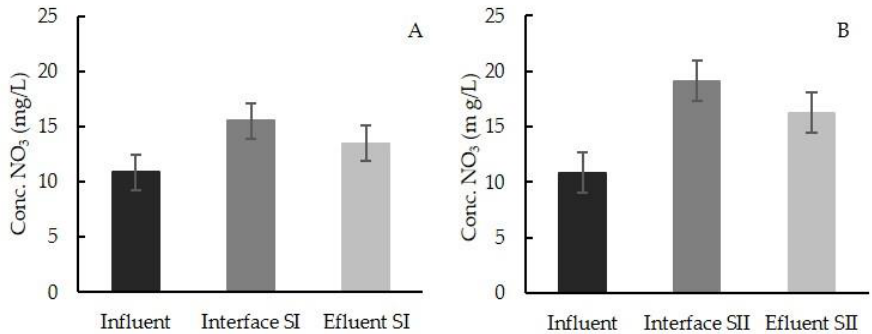
Figure 12. Average concentrations of nitrate in three points of SI ( A ) and SII ( B ) (mean ± standard error).